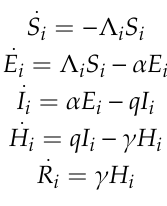
Figure 4. Schematic diagram for the mathematical model.